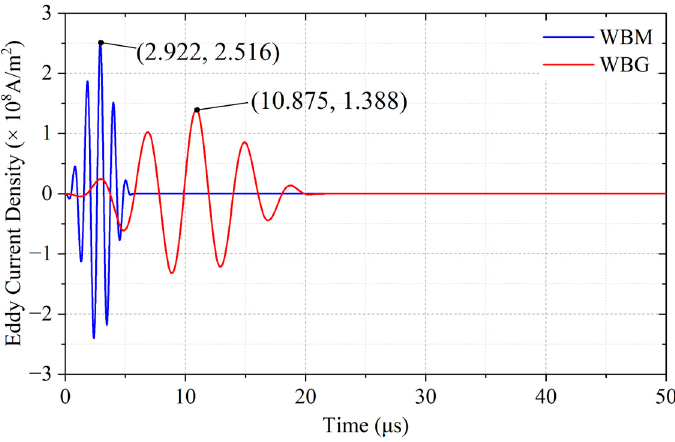
Figure 7. Eddy currents at P0 for the WBM and WBG models.